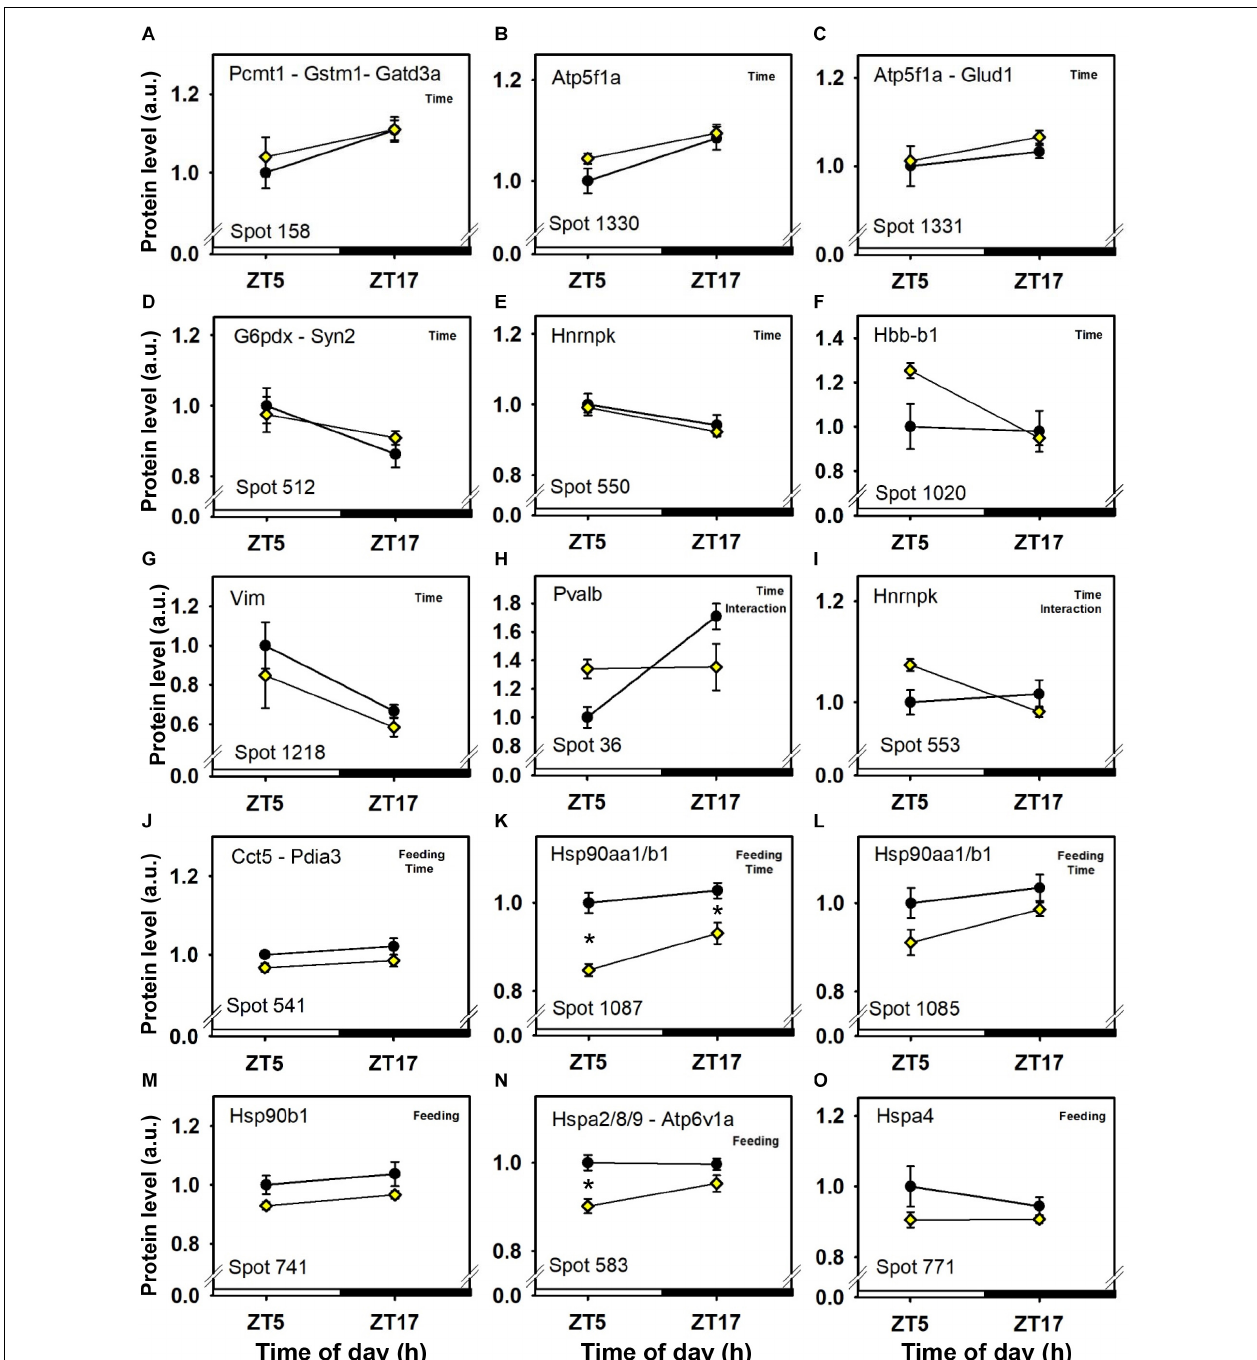
FIGURE 3 | Day–night expression of cerebellar proteins mostly affected by time-of-day. From analyses in control mice fed ad libitum (closed circles) and mice exposed to daytime restricted feeding (yellow diamonds), “Time,” “Feeding,” and “Interaction” indicate significant ( P < 0.05) main effects of time-of-day, feeding conditions or time-of-day × feeding interactions, respectively, as detected by two-way ANOVA (see section “Materials and Methods” for details). * P < 0.05 after post hoc Tukey comparison. Different part labels have been attributed to each differentially-expressed proteins; see details in the main text.